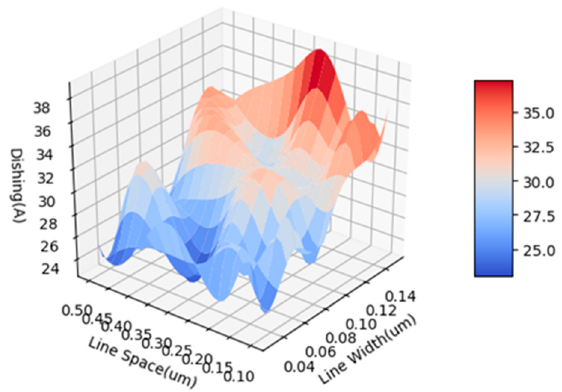
Figure 7. The dishing defects of the predictions of the common NN-based CMP model. The RMSE is 3.56 A.